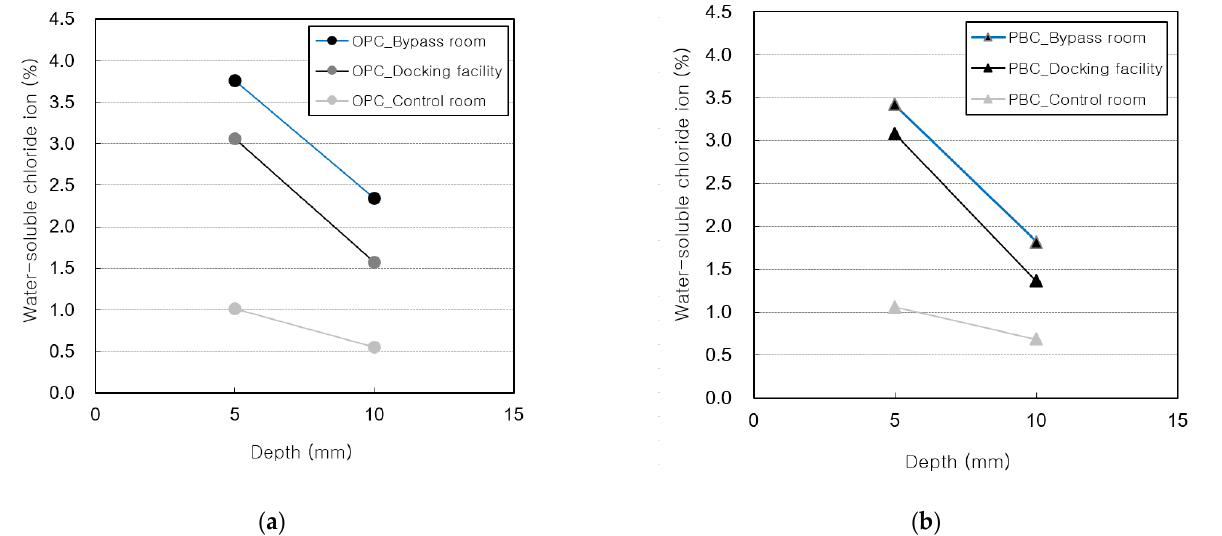
Figure 11. Water-soluble chloride-ion content vs. depth: ( a ) OPC specimens; ( b ) PBC specimens.